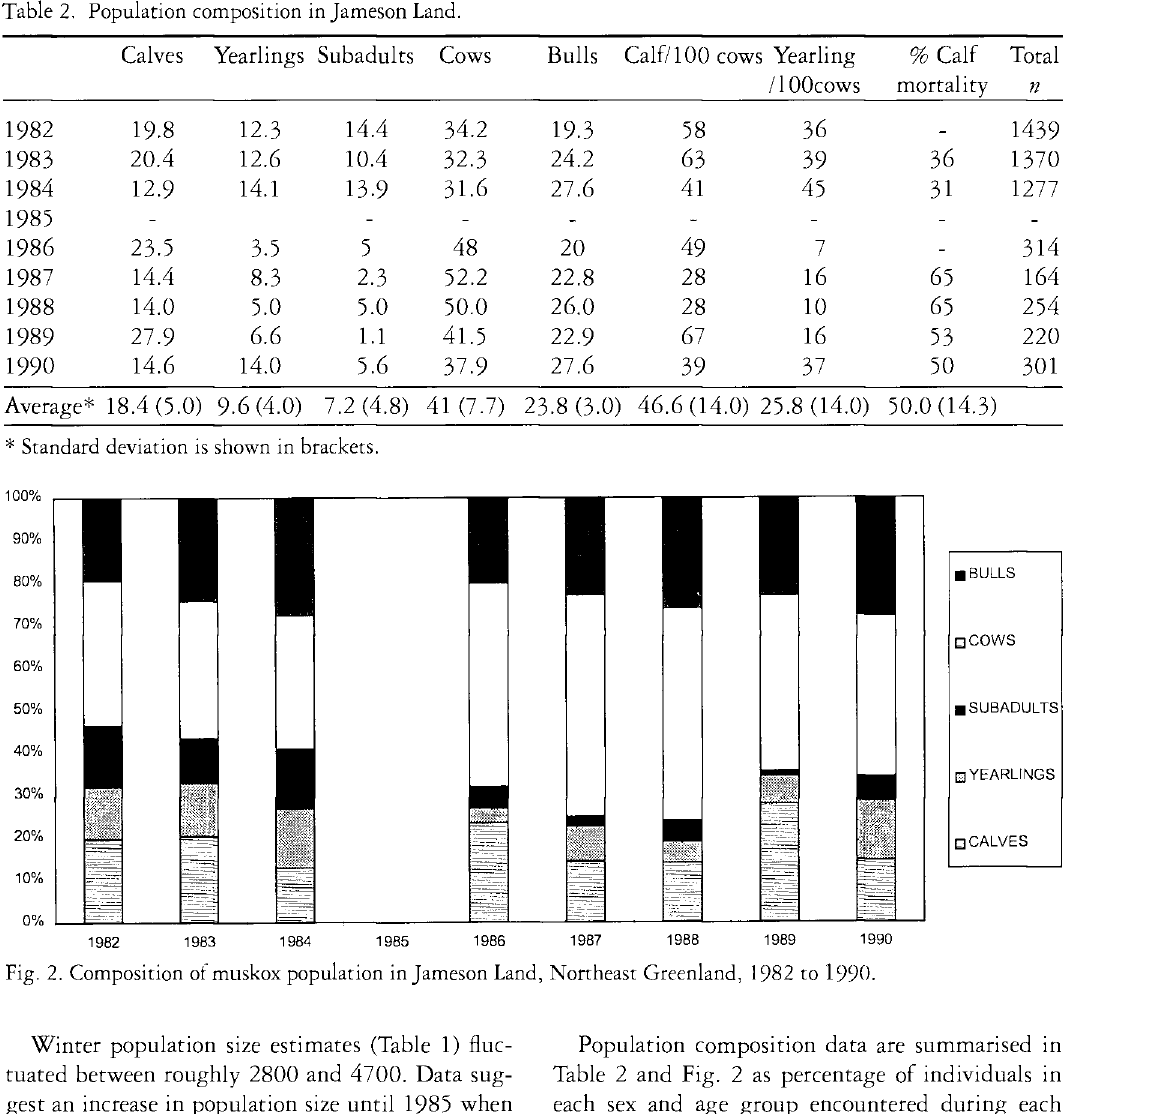
Winter population size estimates (Table 1) fluc tuated between roughly 2800 and 4700. Data sug Table 2 and Fig. 2 as percentage of individuals